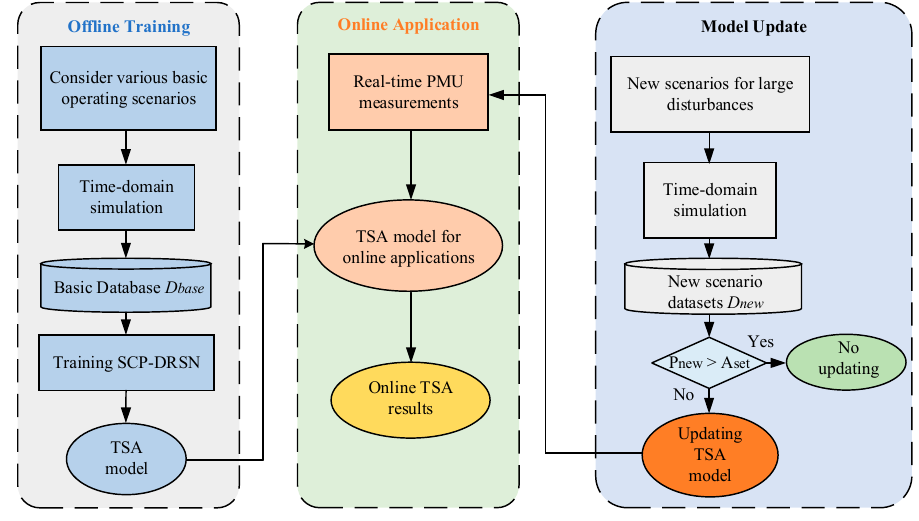
Figure 6. Flowchart of the proposed method.